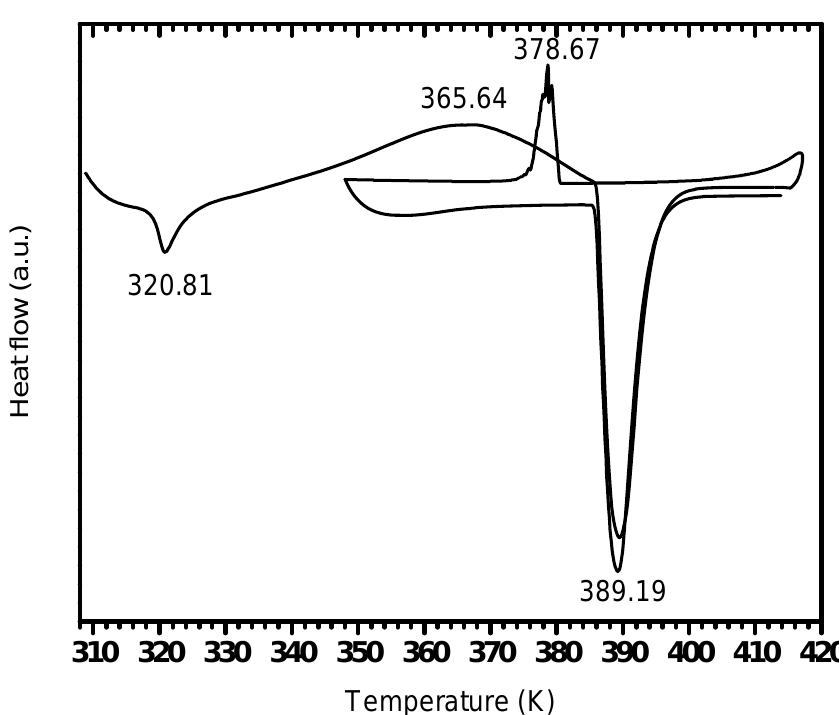
Figure 5. Scanning PDSC trace under argon of unmilled LiBH exposure. Heating and cooling rates: 20 K min –1